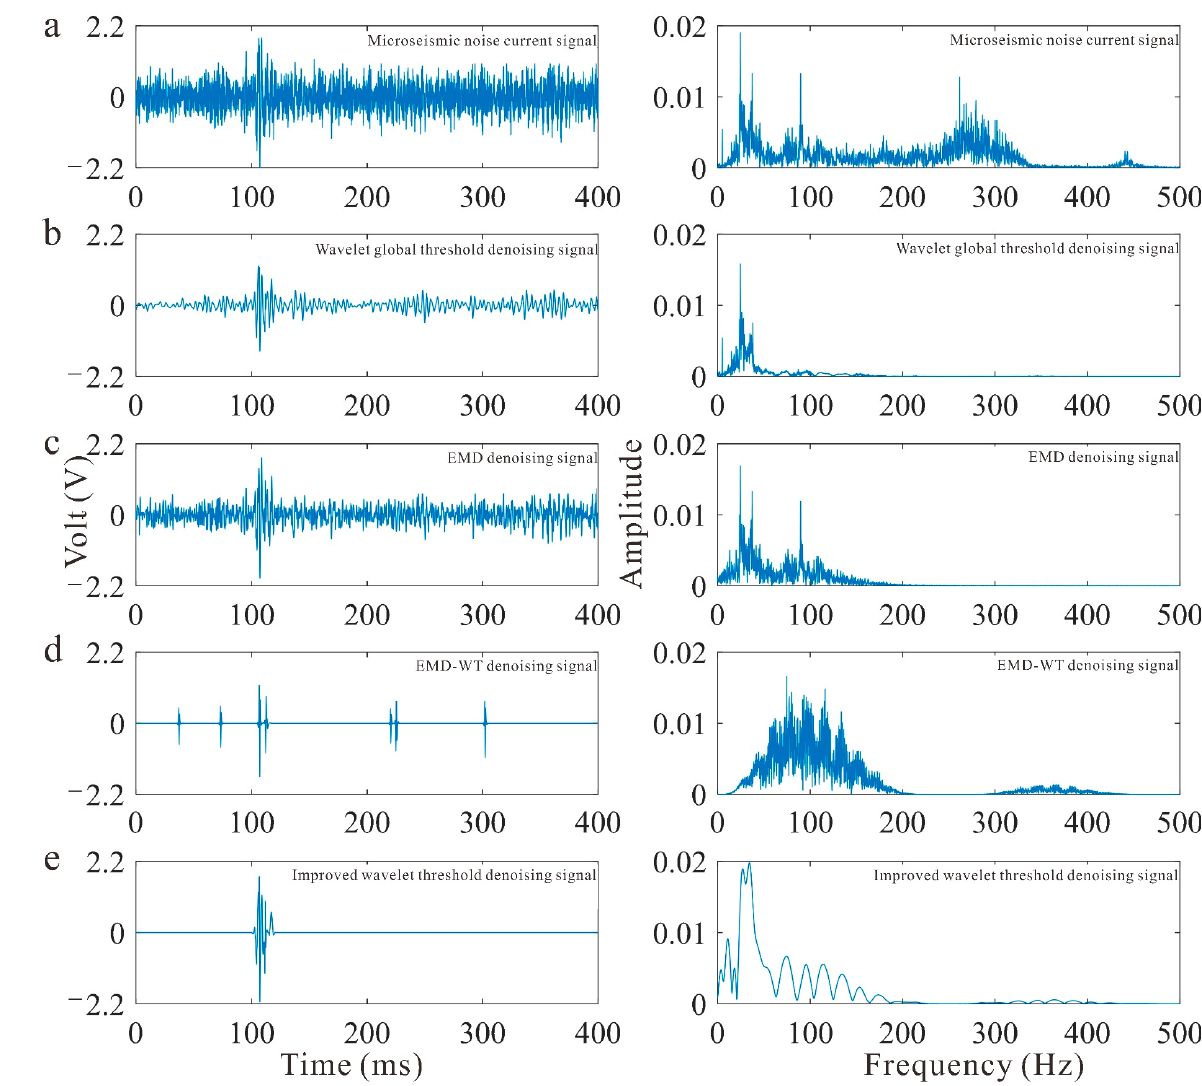
Figure 14. Comparison of denoising effects for an actual microseismic signal with noise and current: ( a ) microseismic noise current signal, ( b ) Wavelet global threshold denoising signal, ( c ) EMD denoising signal, ( d ) EMD-WT denoising signal, ( e ) improved wavelet threshold denoising signal. Table 4. The SNR MSE and r values after denoising based on an actual microseismic signal.